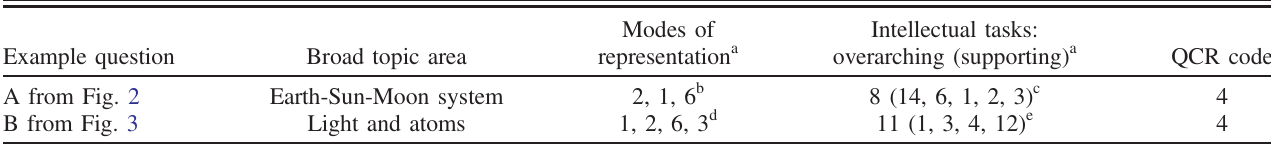
TABLE III. Results of coding the questions in Figs. 2 and 3 using our curriculum characterization framework from Sec.